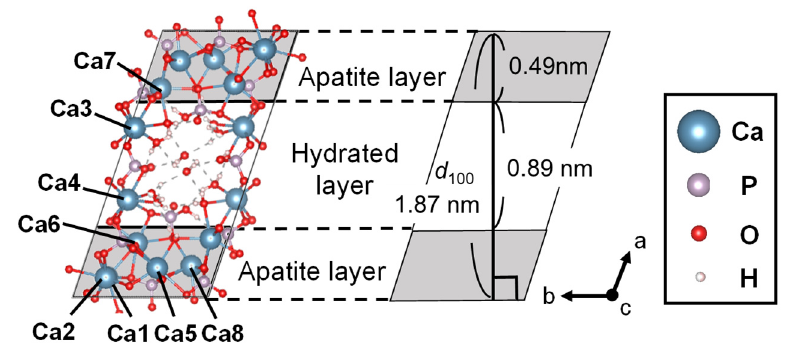
Figure 2. Crystal structure of OCP and distance in OCP structure indicated by d 100 .